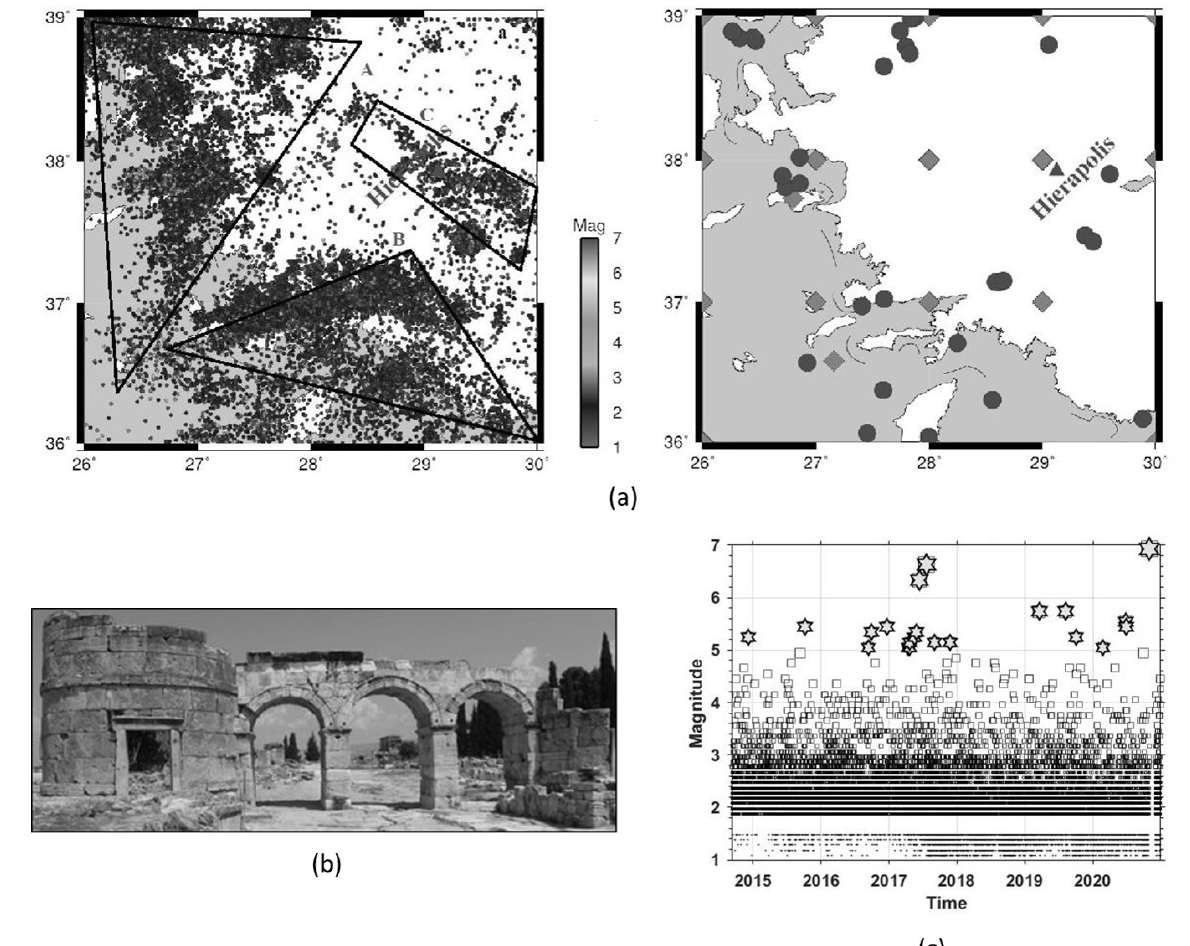
Figure 1 (a). Spatial distribution of local earthquakes (Md≥1) produced using the original catalog data. The color bar on the right shows the magnitudes of earthquakes. Triangle shows the location of the Roman city of Hierapolis in Denizli. The earthquake catalog of KOERI-Retmc (Bogazici University, Kandilli Observatory and Earthquake Research Institute, Regional Earthquake-Tsunami Monitoring Center) was used for this map from 7 September 2014 to 31 December 2020. Black shapes indicate subregions divided according to the earthquake clusters. Grey Circles show significant historical earthquakes based on the Ministry of Interior Disaster ad Emergency Management Presidency (AFAD) and black circles represent the intermediate and larger magnitudes earthquakes. (b) View of the Frontinus Gate in Hierapolis. (c) Earthquake magnitude time series since 7 September